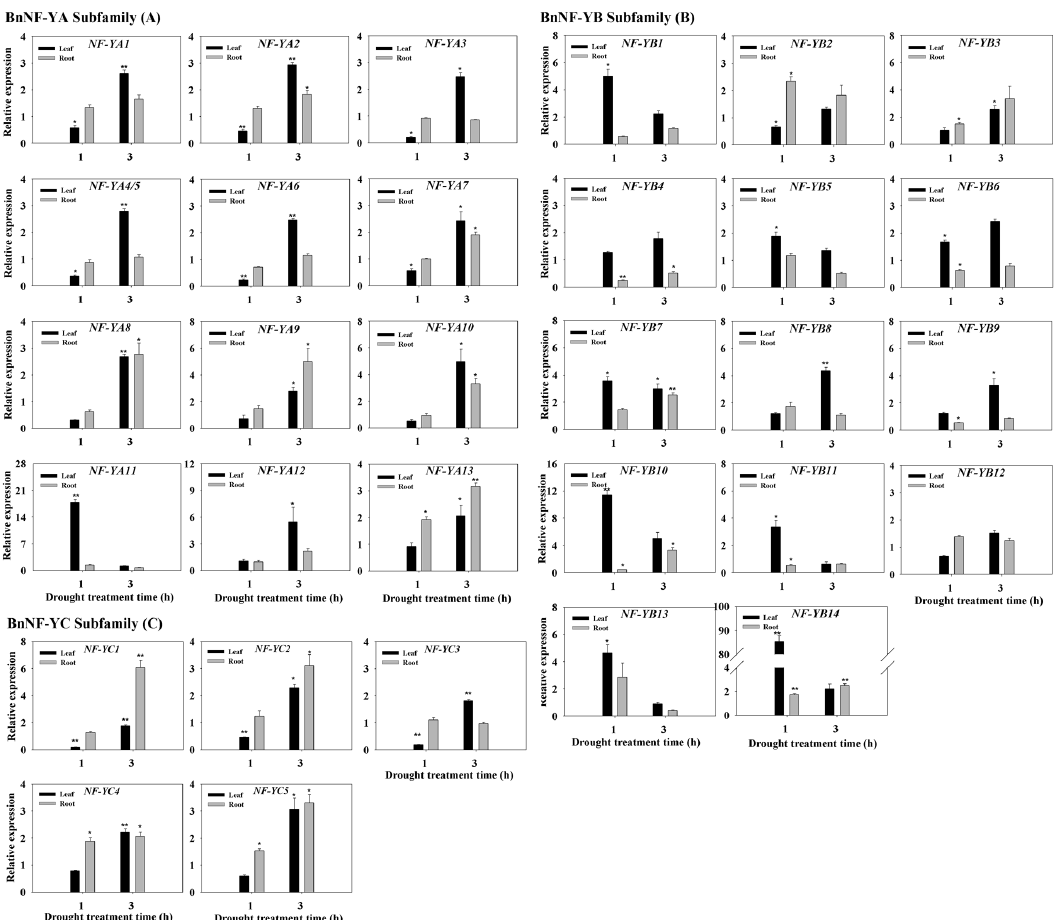
Figure 2. Expression pattern of the BnNF-Y genes in plants subjected to drought stress. The expression of BnNF-YA (A), BnNF-YB (B), and BnNF-YC (C) genes in the leaves and roots of plants exposed to 15% (w/v) PEG6000. Three-week-old canola seedlings were treated with 15% (w/v) PEG-6000 for 1 and 3 h. Total RNA was extracted from leaves (L) and roots (R) for quantitative PCR (qRT-PCR) analysis. Transcript levels of each BnNF-Y were first normalized to those of the housekeeping gene 18S and then compared to each time-point control. Each data point represents the mean 6 SE of three independent experiments. Significant differences between treated samples and untreated controls (same tissue only) are indicated by single (P , 0.05) or double (P , 0.01) asterisks, according to Dunnett’s method of one-way ANOVA in SPSS. Expression levels in untreated samples (CK, 1-h or 3-h leaf and root samples) were arbitrarily set to 1.0.